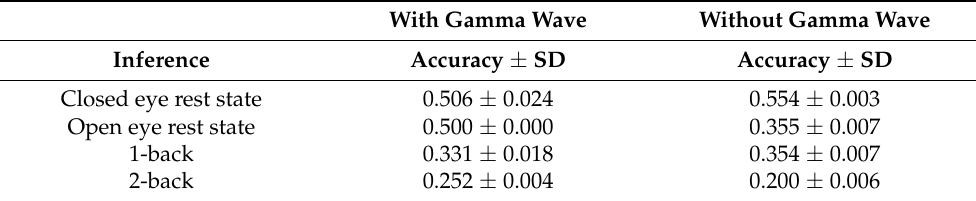
Table 2. Results of inferences by the linear discriminant analysis random forest (LDARF) classifier during mouth breathing with O 2 supply. The results of the inferences on the electroencephalography (EEG) data in three different levels of oxygen demand obtained using the LDARF classifier are shown. The classifier was trained with 500 data from closed eyes rest state during mouth breathing. It should be noted that the precision was always equal to one because O 2 was supplied through mouth and that the sensitivity was the same as the accuracy. With Gamma